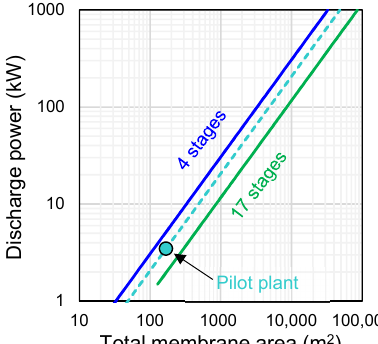
Figure 5. Discharge power as a function of the total membrane area for four-stage ( N s = 4) and 17-stage ( N s = 17) ABFB systems, and for the single stage pilot system (the highlighted point refers to the four-stack pilot plant). Each stage/stack is simulated with a membrane active area of 0.5 × 0.5 m 2 .